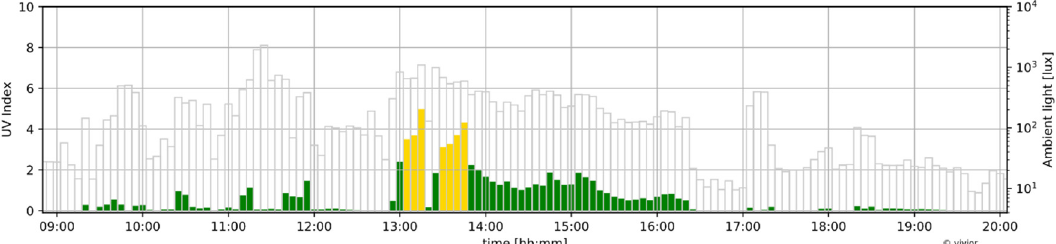
Figure 5. Example of the ultraviolet light exposure (quantified with UV index) as solid colored bars compared to ambient light level shown as empty bars during a measurement day shown in Figure 4 (Patient B). The level of ultraviolet light indicates that the example day was mostly spent outdoors. Table 1. Vivior feasibility study sites, ethics committees, and enrollment. Study